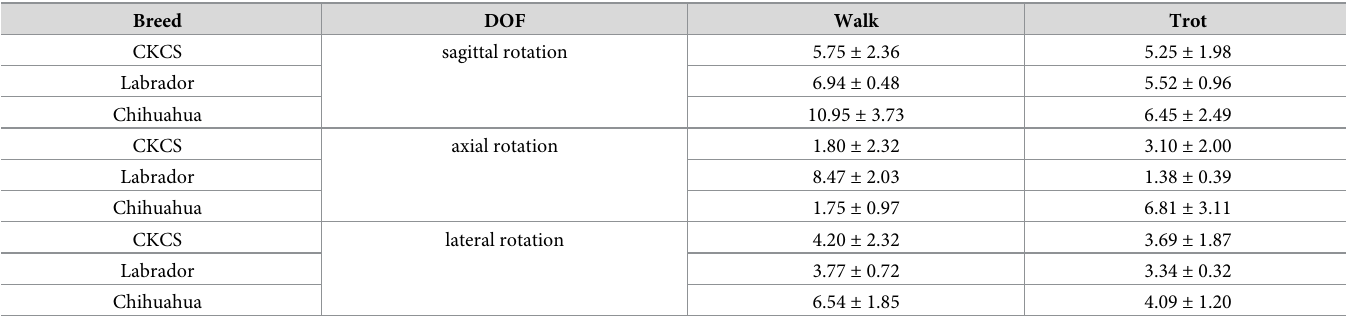
Table 4. Range of motion of the rotations of C1/skull IVJ (atlantooccipital joint).